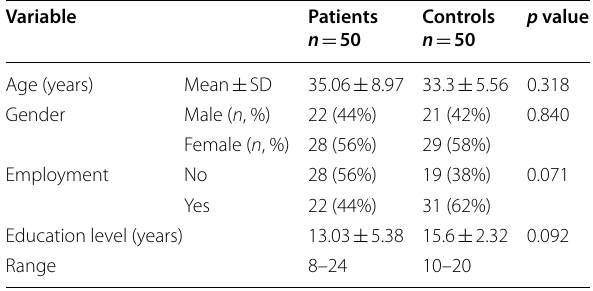
SD standard deviation, n